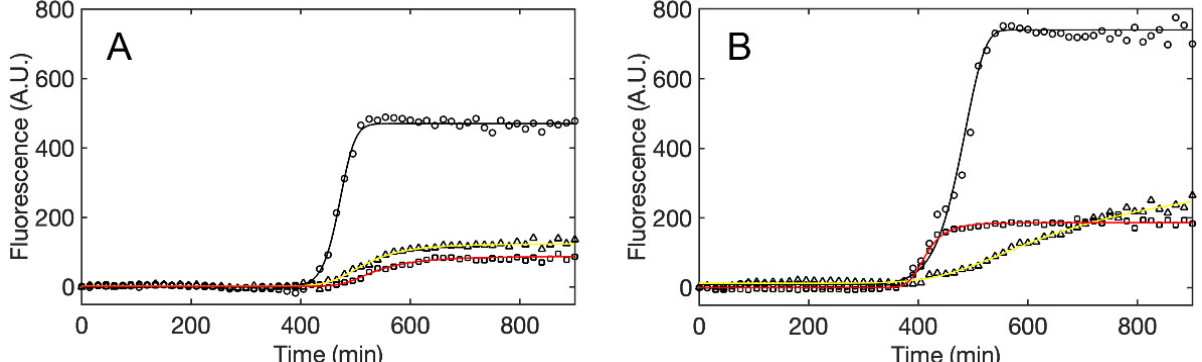
Figure 3. Comparison of aggregation kinetics of A β (1–40) and A β (1–42) fibrils (( A ) and ( B ) panels, respectively) grown at 37 °C, in the absence ( ○ ) and in the presence of 20 μ M curcumin ( △ ) and RuCurcumin ( □ ), without continuous agitation.